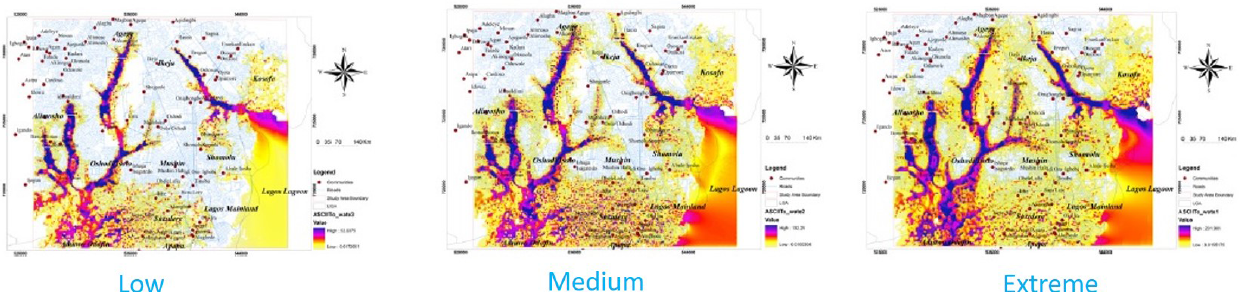
Figure 4. Flood vulnerability of Lagos metropolis.